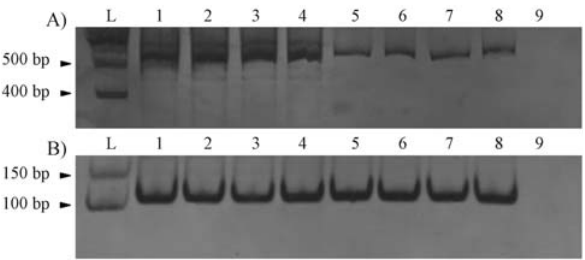
Figure 1 - A) Detection of CTCF transcripts: (1) immature oocytes, (2) mature oocytes, (3) 2 to 4 stage embryos, (4) 8 to 16 stage embryos, (5) 16 to32stageembryos,(6)morulae,(7)blastocystsand(7)blood.(L)Molec- ular marker, (9) Negative control. B) Detection of β -actin transcripts: same as 1 to 8